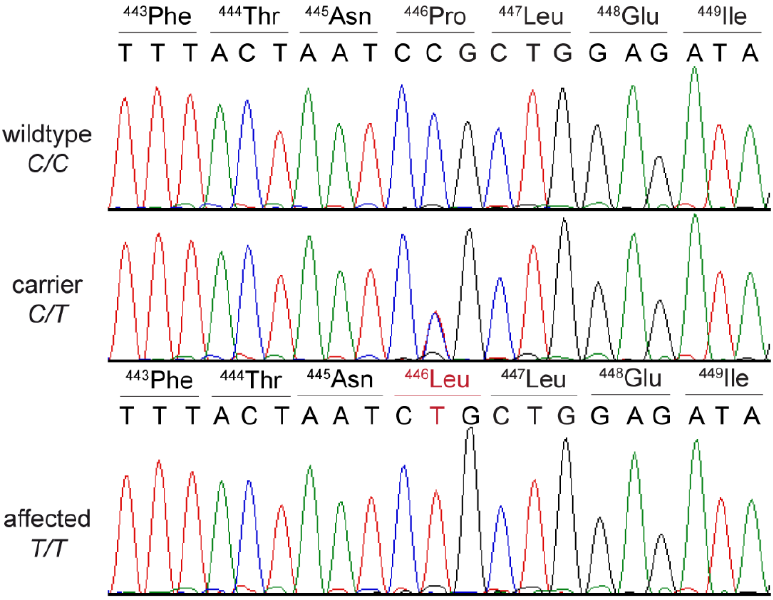
Figure 1. Details of the SLC25A12 :c.1337C>T variant (p.Pro446Leu). Representative electrophero- grams of dogs with the three different genotypes are shown. The amino acid translations of the wild type and mutant alleles are indicated.